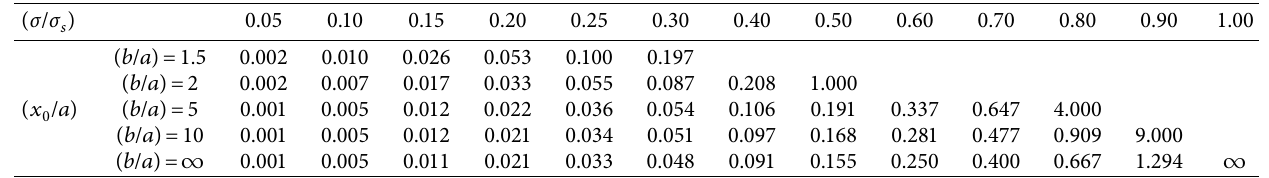
Figure 4: Comparison of the variation of ( x Table 1: Variations of ( x / a ) with ( σ / σ s ) in several instances for ( b / a ) � 1 . 5 , 2 , 5 , 10 , and ∞ . 0